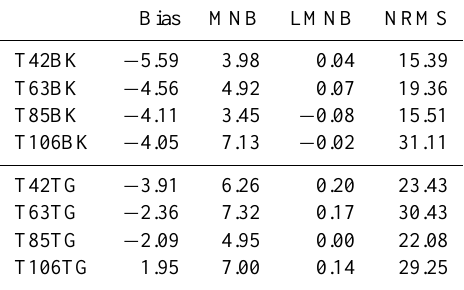
Table 2. Skill scores resulting from the comparison of the eight time slice simulations with in situ measurements of dust deposition and surface dust concentration from Ginoux et al. (2001), Tegen et al. (2002), Stier et al. (2005), and Mahowald et al.